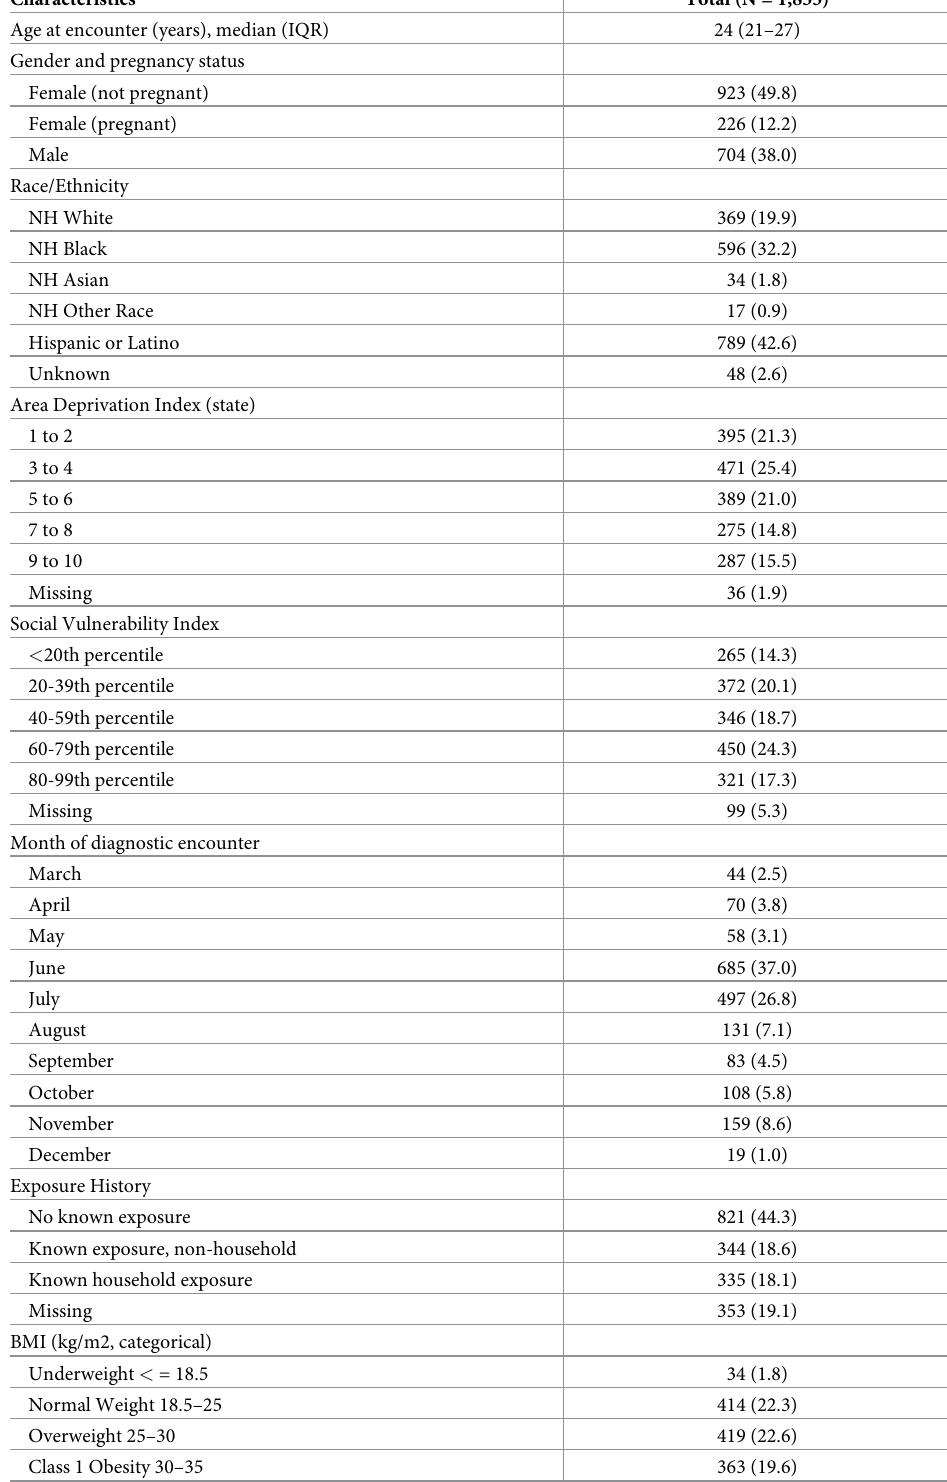
Table 1. Characteristics of COVID patients aged 18–29 years, diagnosed at a hospital